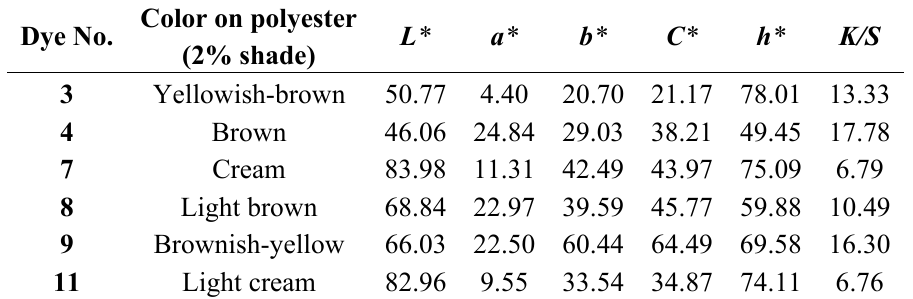
Table 1. Shade and optical measurements of the azo disperse dyes on the polyester fabrics. Dye No.